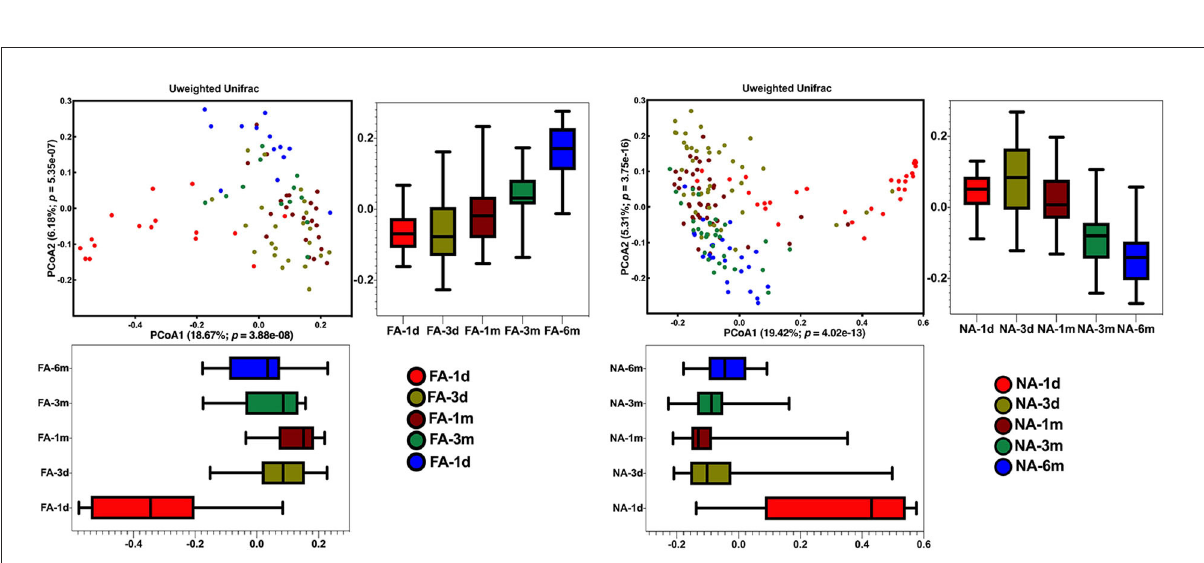
FIGURE4 Differences in beta diversity over time between non-allergy (NA) and food allergy (FA) groups, as determined using principal coordinates analysis (PCoA) combined with Adonis analysis. P < 0.05 indicates a statistical significance.